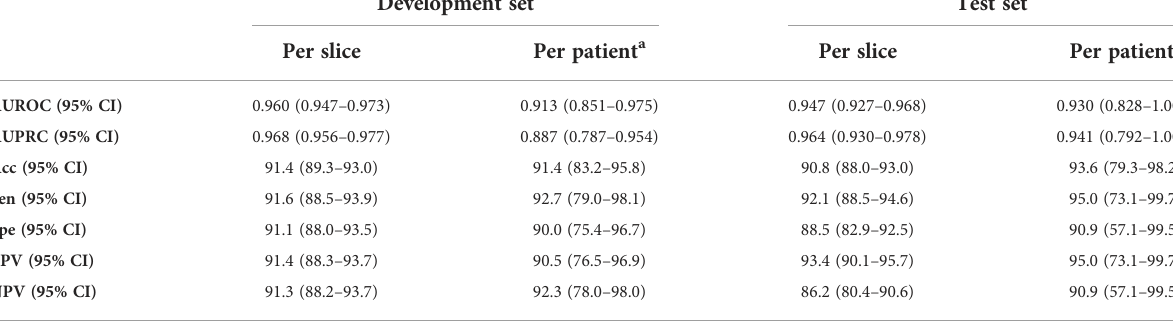
TABLE 3 Diagnostic performance of the hybrid model for the prediction of mitotic